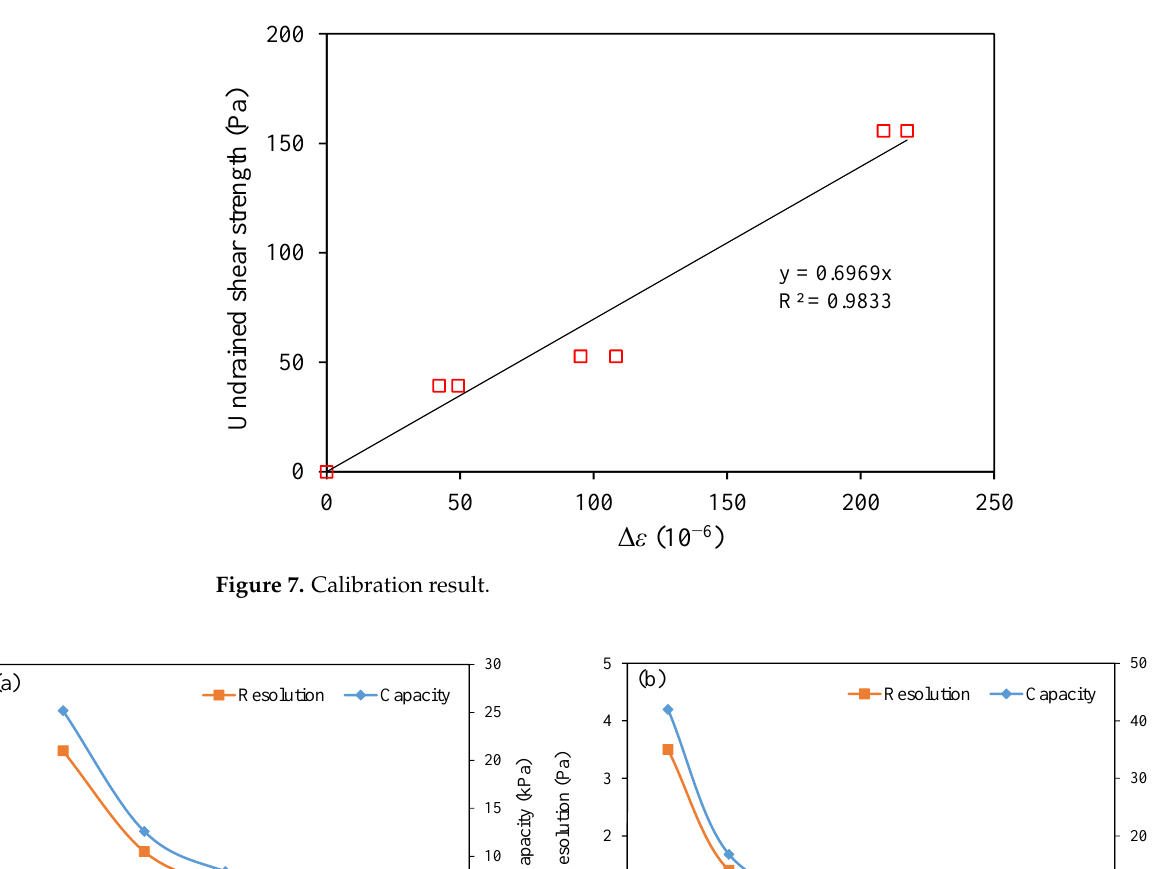
Figure 6. Reference undrained shear strength of HKMD with different water contents obtained from vane shear tests.